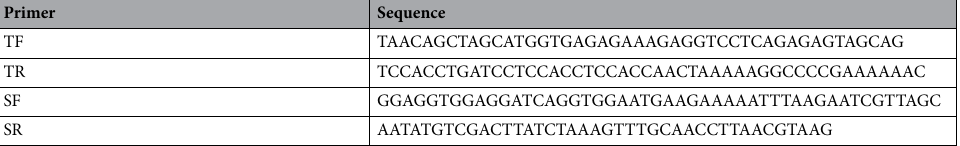
Table 1. Sequence of primers required for construction of trail‑linker‑SlpA fragment, cloned in pET-28a (+) plasmid; highlighted part indicates linker